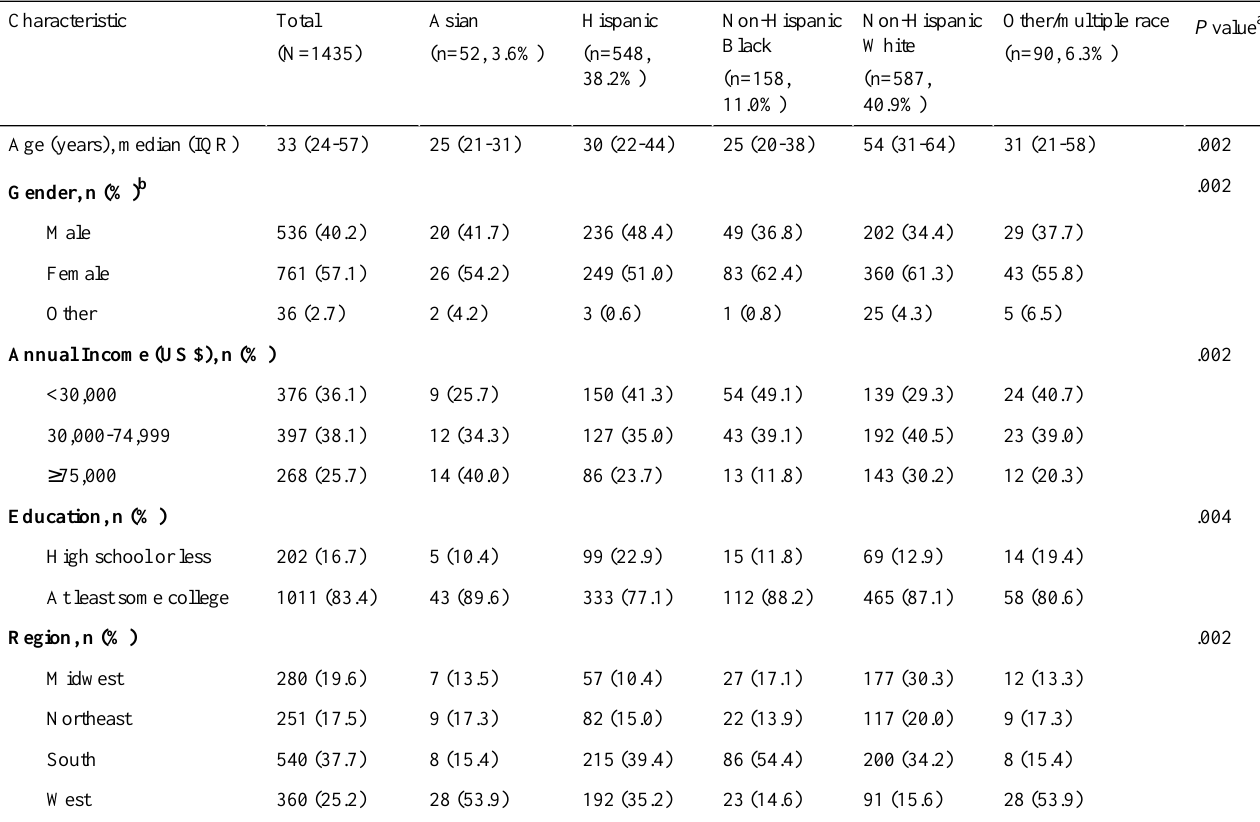
Table 1. Demographic characteristics of participants in a cross-sectional web-based survey of COVID-19 symptoms and knowledge from March 27 through April 1, 2020